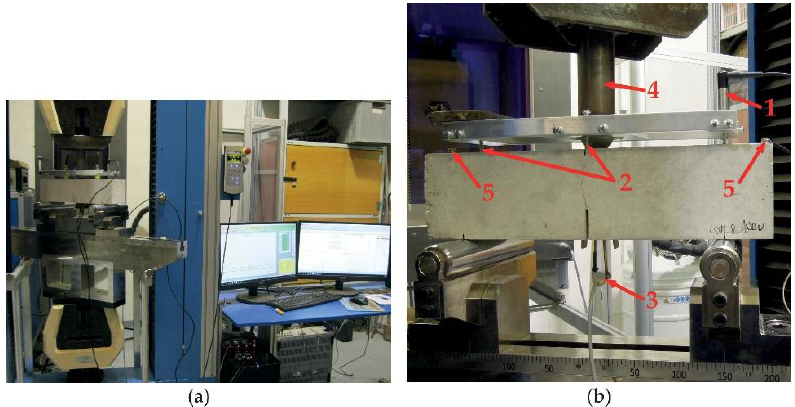
Figure 3. ( a ) Arrangement of fracture tests; ( b ) details of the test specimens and sensors (1—inductive sensor in a frame; 2—rectifying screws in the middle of the span and above the support; 3—strain gauge between the blades; 4—applied load; 5—acoustic emission sensors).